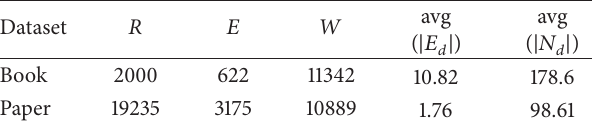
Table 2: Summary statistics of the